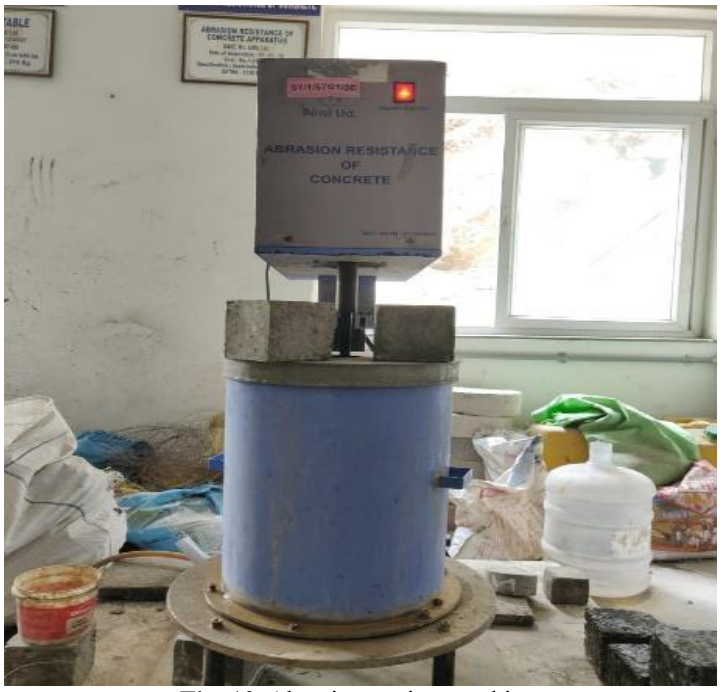
Fig. 10. Abrasion testing